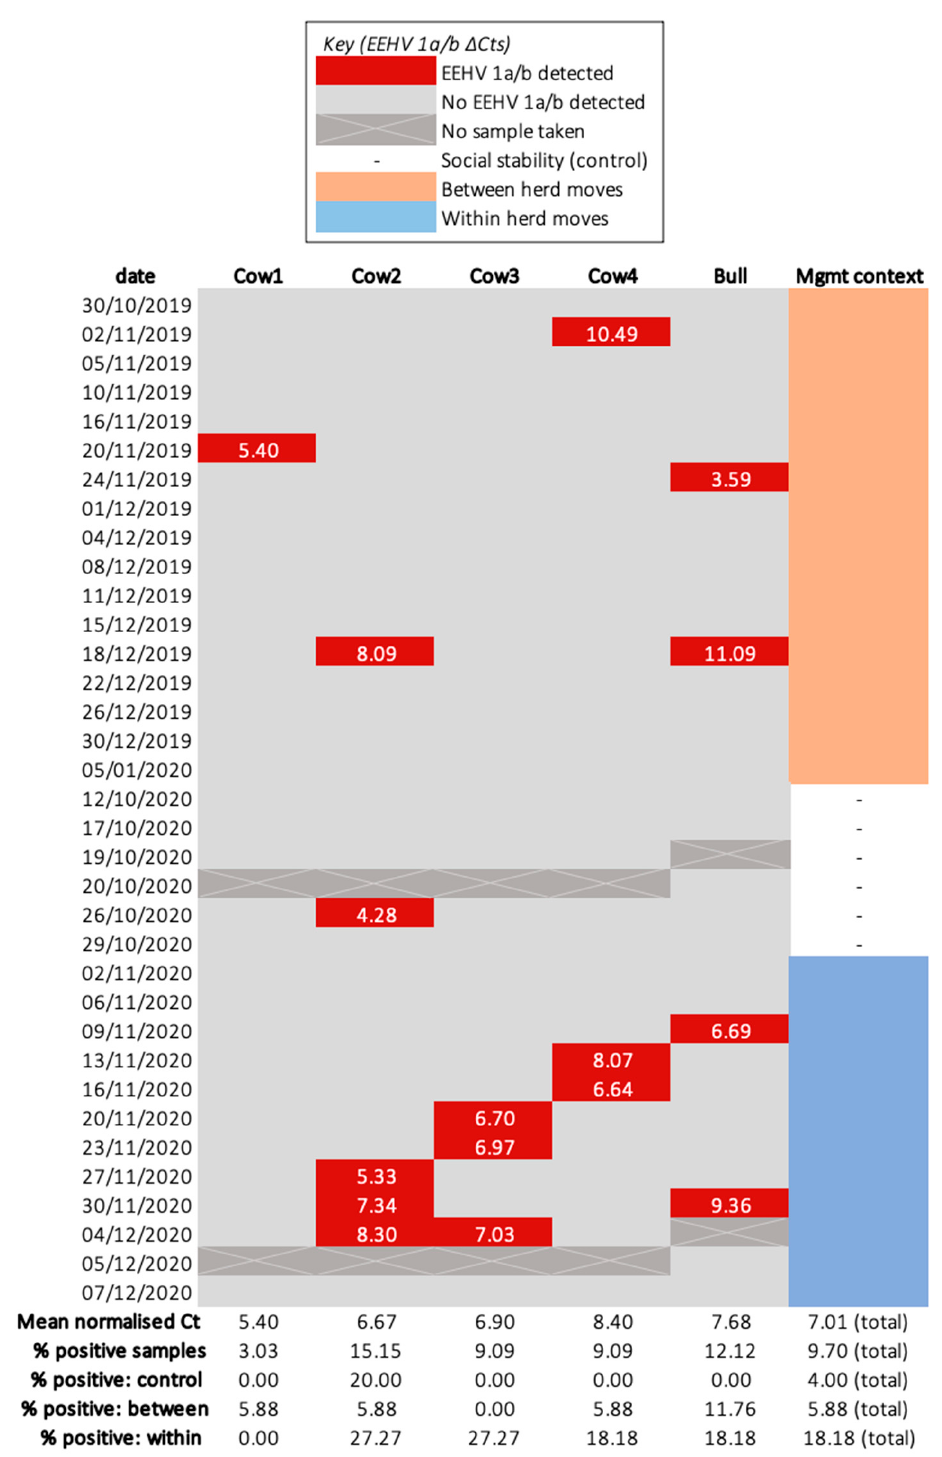
Figure 3. Heatmap of normalised EEHV 1a/b shedding ( Δ Ct) for each sampled elephant. The percentage of samples exhibiting an EEHV 1a/b and EF–1– α Ct below 43 is indicated within the “% positive” rows for each individual elephant and the total herd. This value was calculated by dividing the quantity of samples possessing EEHV 1a/b by the total number collected within the corresponding period and multiplying by